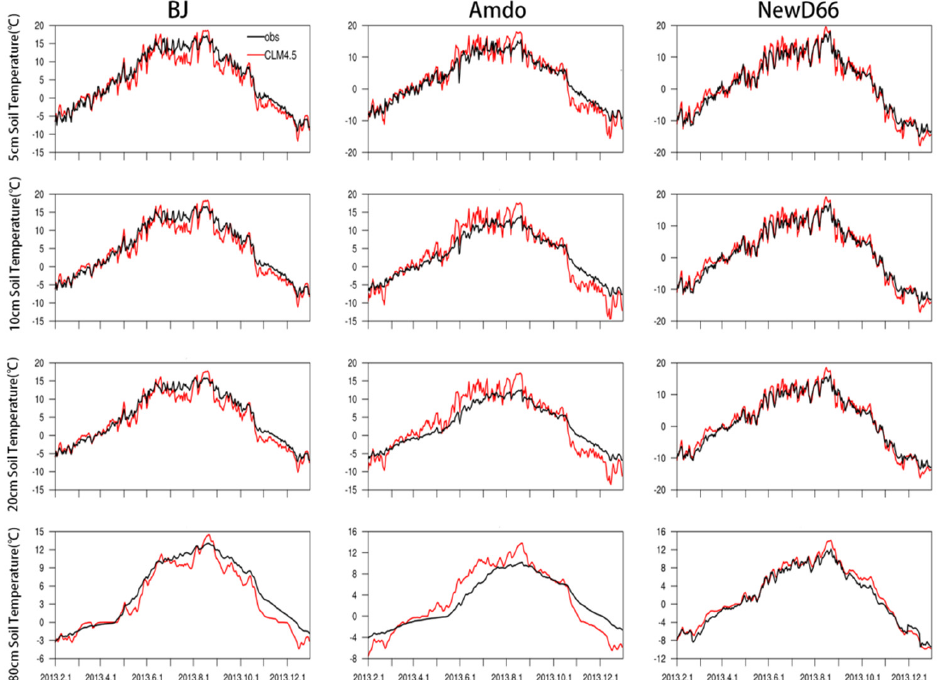
Figure 2. Comparison of simulated and observed soil temperature in 4 soil layers at BJ site, Amdo site, and NewD66 site.